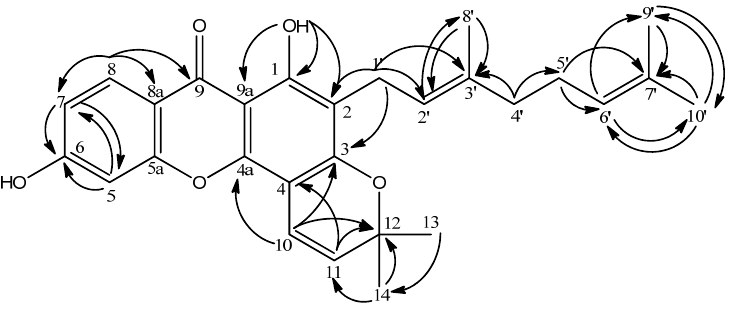
Figure 4. HMBC Correlations in Compound 2